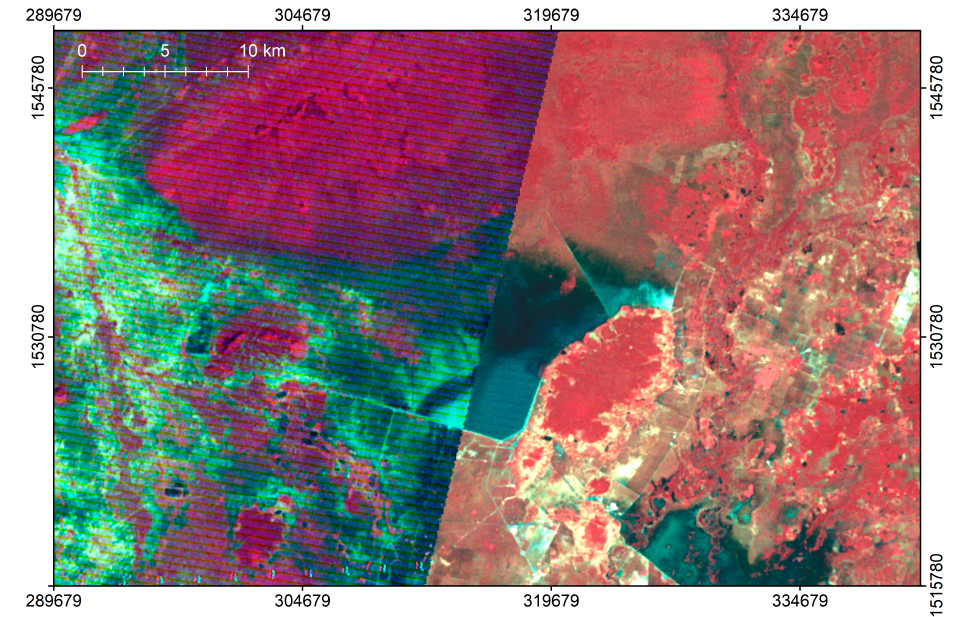
Figure 4. Closeup of two Landsat scenes, showing severe data striping on the left.